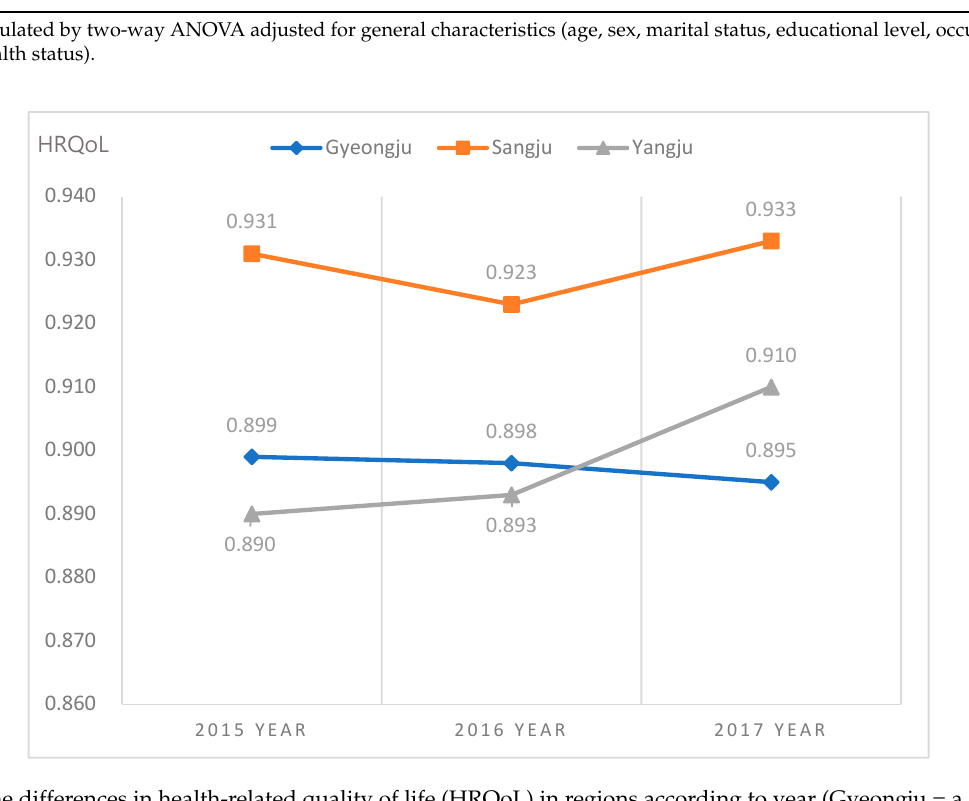
Figure 2. The differences in health-related quality of life (HRQoL) in regions according to year (Gyeongju = a, Sangju = b, Yangju = c; Bonferroni = a, c < b in 2015 and 2016, and a < c < b in 2017).